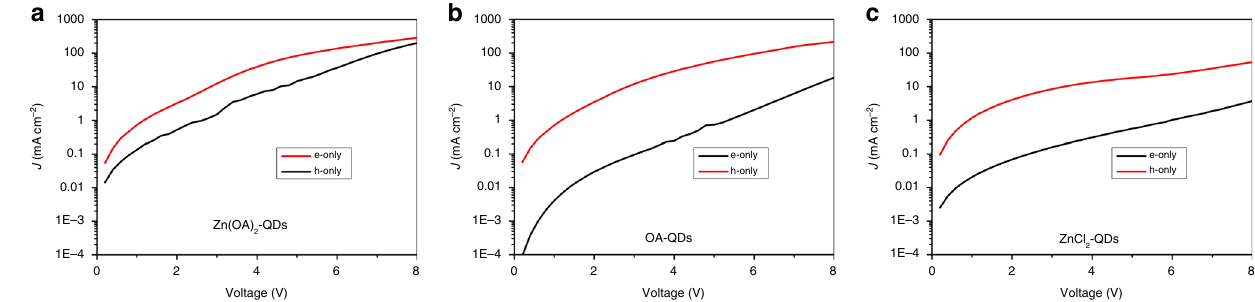
Fig. 6 Single Carrier Devices. Current density vs. Voltage plots of Single carrier devices: a Zn(OA) 2 -QDs, b OA-QDs, and c ZnCl 2 -QDs.